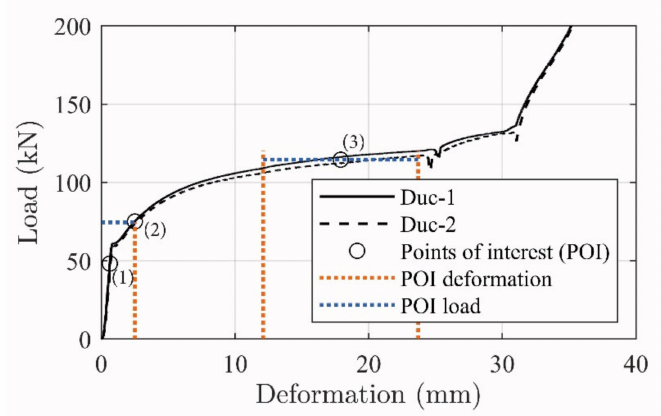
Figure 16. Ductile mechanism response magnitudes at the (1), (2), and (3)